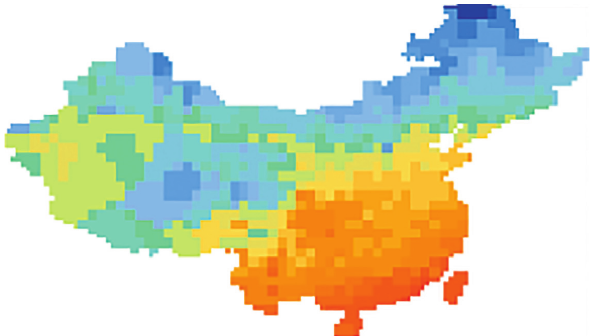
Figure 2: Visualized temperature map.